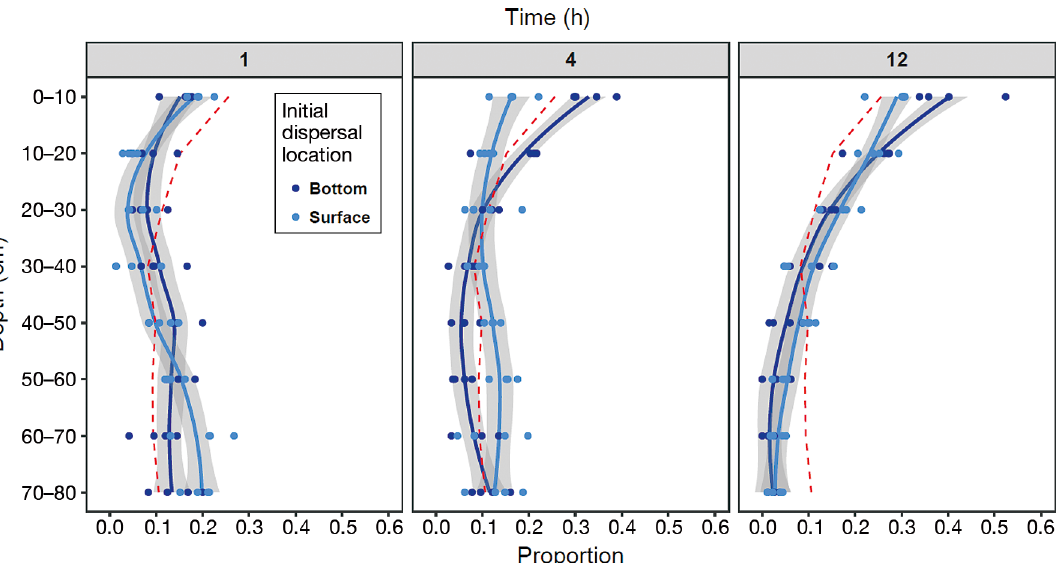
Fig. 4. Proportion of salmon lice Lepeophtheirus salmonis copepodids found in 10 cm increments within the column (0−80 cm) exposed to 0 μmol m −2 s −1 after 1, 4 and 12 h. Lice were released from either the surface or the bottom of the column at the be- ginning of the experiment. Points: individual data points; lines: smoothed loess average; shading: SE. Red dashed line: overall average used to compare distributions in generalised additive model